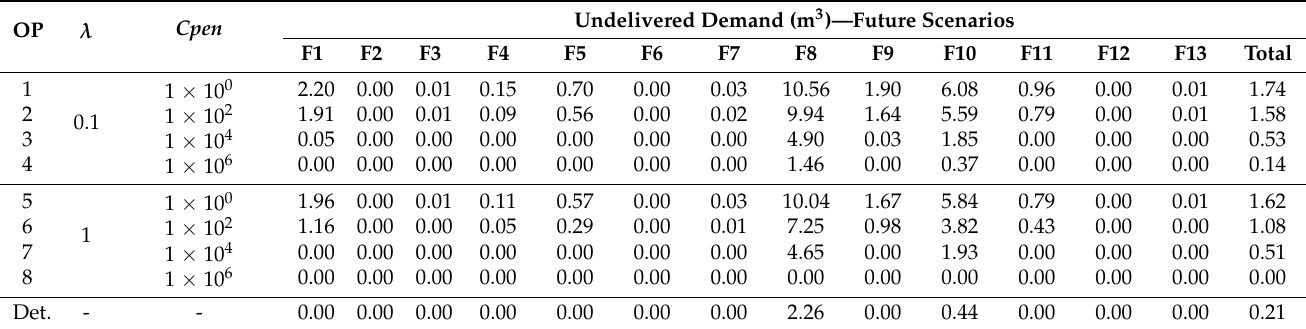
Table 8. Performance of the design solutions obtained considering the historic scenarios under the future demand scenarios. The performance is evaluated in terms of undelivered demand (m 3